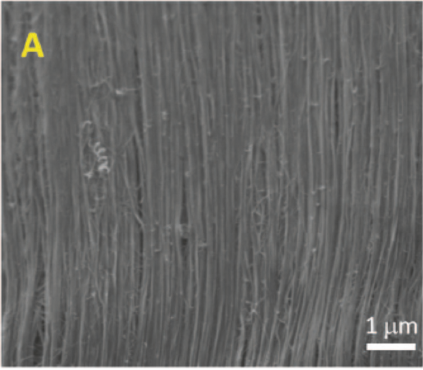
Figure 10: SEM of vertically aligned CNT fiber spun with chloro- sulfonic acid [33]. Reprinted from